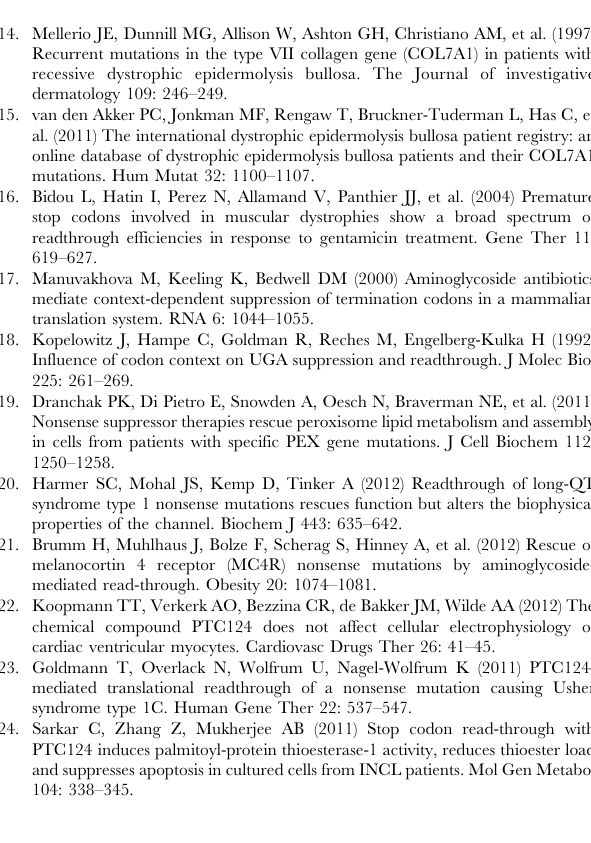
Figure S1 Figurative description of the various reporter assays used in the study indicating the sequence context and relative position of premature stop codons within the gene. (PDF) Figure S2 LCMS analysis of PTC124. Figure S3 NMR analysis of